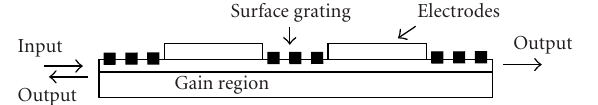
Figure 1: Block diagram of an active lattice filter based on surface grating interstage couplers and semiconductor optical